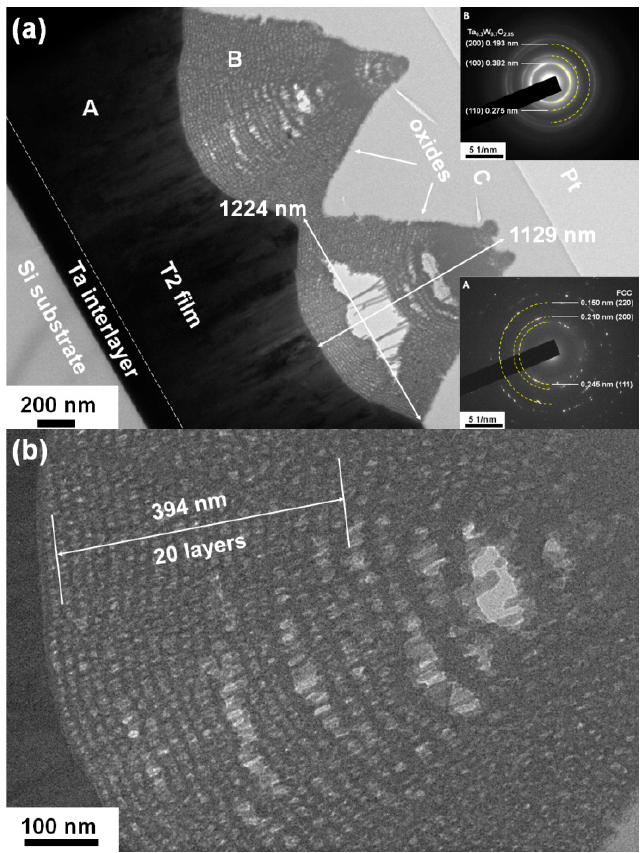
Figure 14. ( a ) XTEM image and SAED patterns and ( b ) magnified XTEM image of the T2 sample annealed at 600 °C in 1% O 2 –Ar for 8 h.